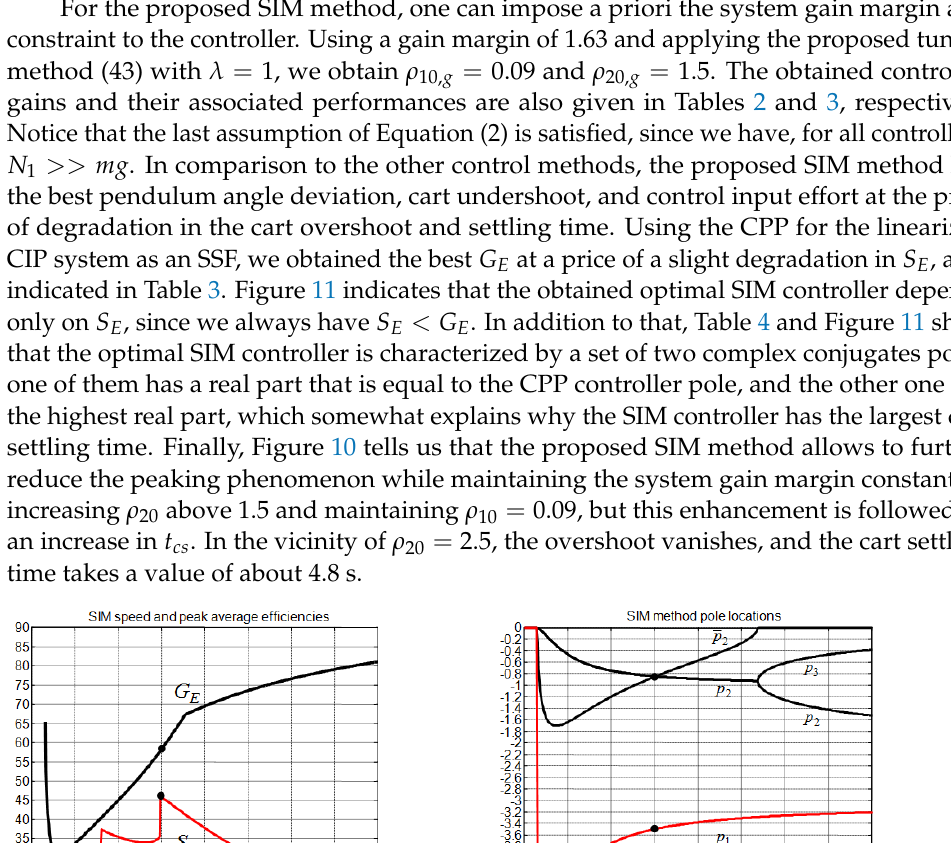
Table 4. Closed-loop poles for the considered controllers.